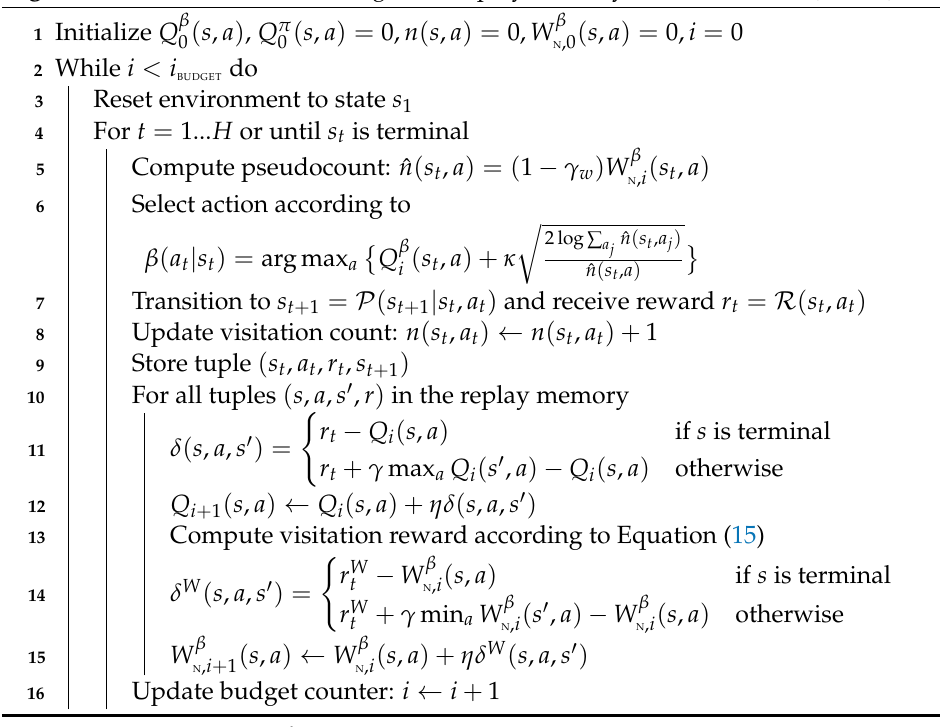
Algorithm A4: Tabular Q-Learning with Replay Memory and Visit. Value